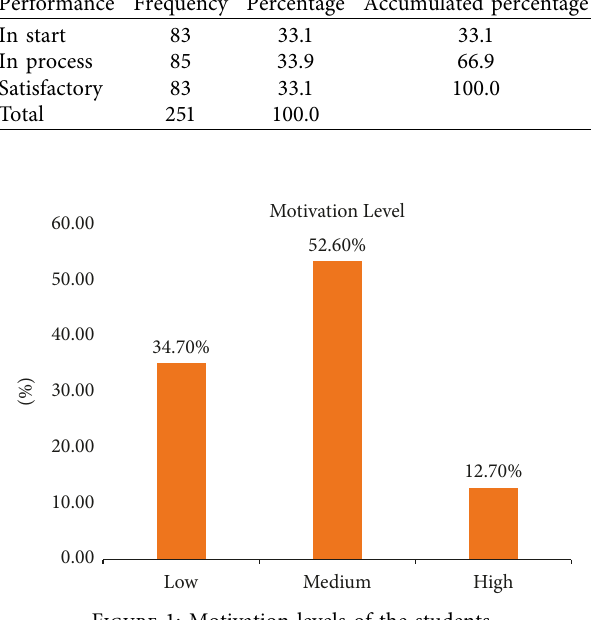
Figure 1: Motivation levels of the